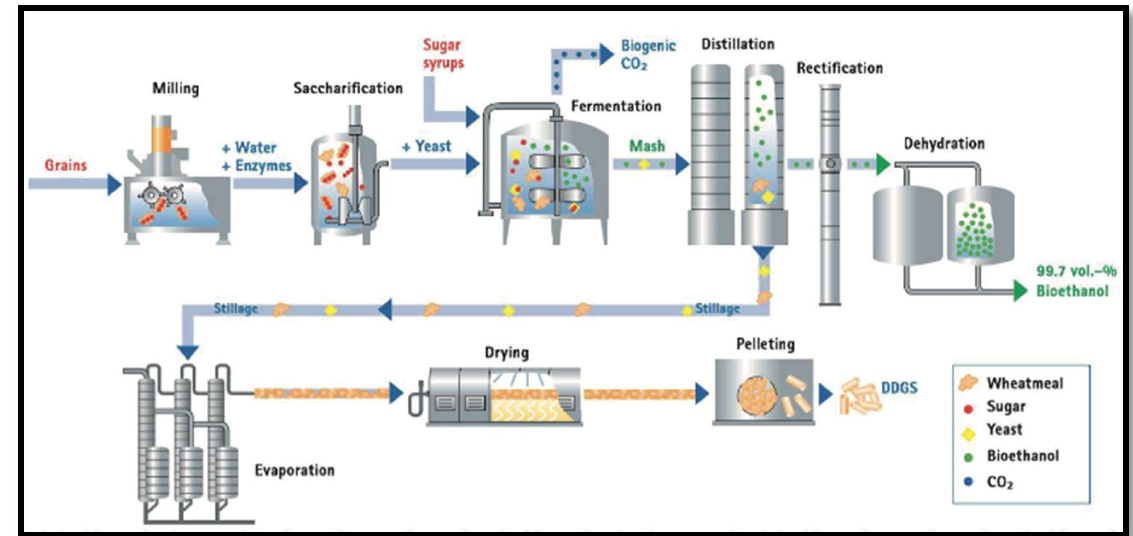
Figure 2. Biochemical conversion of biomass to alcohol fuels (modified from Ref. [30]).